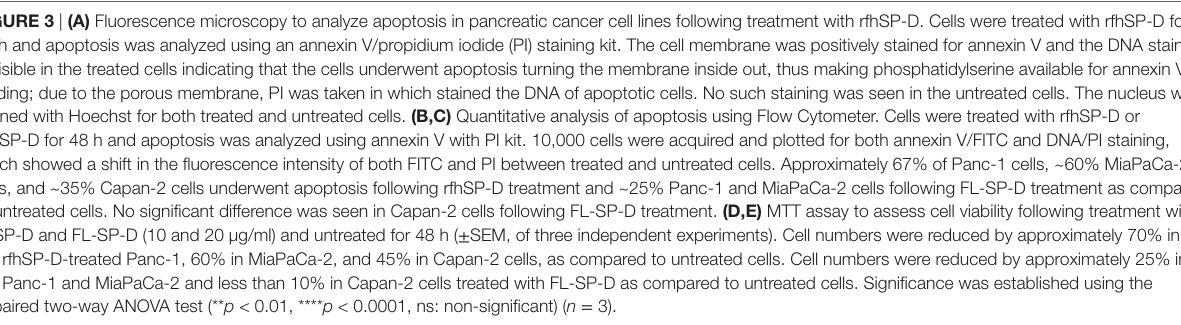
FigUre 3 | (a) Fluorescence microscopy to analyze apoptosis in pancreatic cancer cell lines following treatment with rfhSP-D. Cells were treated with rfhSP-D for 48 h and apoptosis was analyzed using an annexin V/propidium iodide (PI) staining kit. The cell membrane was positively stained for annexin V and the DNA staining is visible in the treated cells indicating that the cells underwent apoptosis turning the membrane inside out, thus making phosphatidylserine available for annexin V binding; due to the porous membrane, PI was taken in which stained the DNA of apoptotic cells. No such staining was seen in the untreated cells. The nucleus was stained with Hoechst for both treated and untreated cells. (b,c) Quantitative analysis of apoptosis using Flow Cytometer. Cells were treated with rfhSP-D or FL-SP-D for 48 h and apoptosis was analyzed using annexin V with PI kit. 10,000 cells were acquired and plotted for both annexin V/FITC and DNA/PI staining, which showed a shift in the fluorescence intensity of both FITC and PI between treated and untreated cells. Approximately 67% of Panc-1 cells, ~60% MiaPaCa-2 cells, and ~35% Capan-2 cells underwent apoptosis following rfhSP-D treatment and ~25% Panc-1 and MiaPaCa-2 cells following FL-SP-D treatment as compared to untreated cells. No significant difference was seen in Capan-2 cells following FL-SP-D treatment. (D,e) MTT assay to assess cell viability following treatment with rfhSP-D and FL-SP-D (10 and 20 µg/ml) and untreated for 48 h ( ± SEM, of three independent experiments). Cell numbers were reduced by approximately 70% in the rfhSP-D-treated Panc-1, 60% in MiaPaCa-2, and 45% in Capan-2 cells, as compared to untreated cells. Cell numbers were reduced by approximately 25% in the Panc-1 and MiaPaCa-2 and less than 10% in Capan-2 cells treated with FL-SP-D as compared to untreated cells. Significance was established using